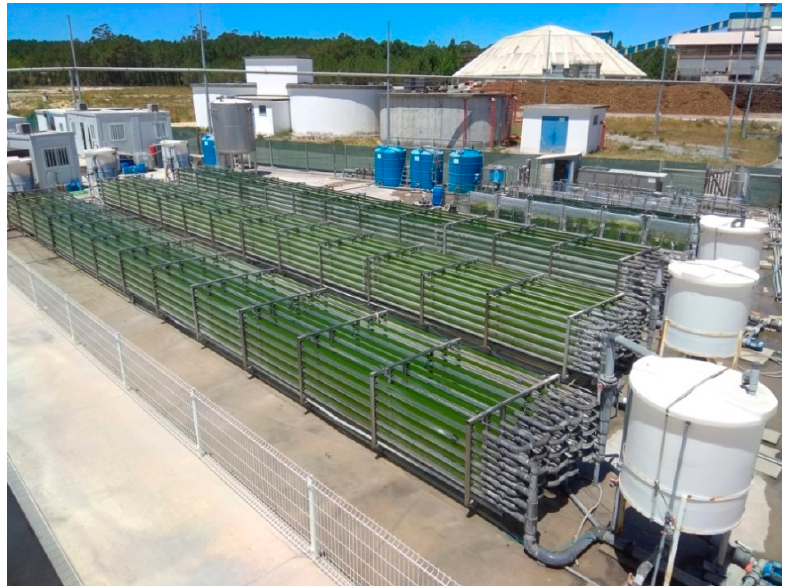
Figure 1. Pilot-scale tubular photobioreactors (PBRs) used in the trials with 2.6 m 3 of working volume (Allmicroalgae, Pataias, Portugal).